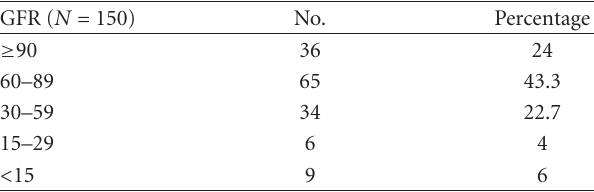
Table 3: Showing the GFR ranges in the subjects.